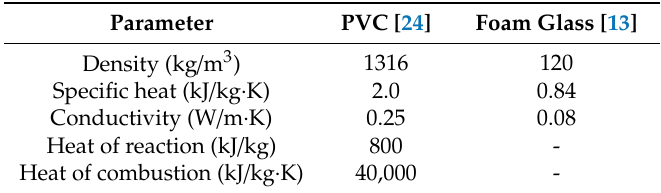
Table 1. Properties of PVC and foam glass for pyrolysis simulation [24].